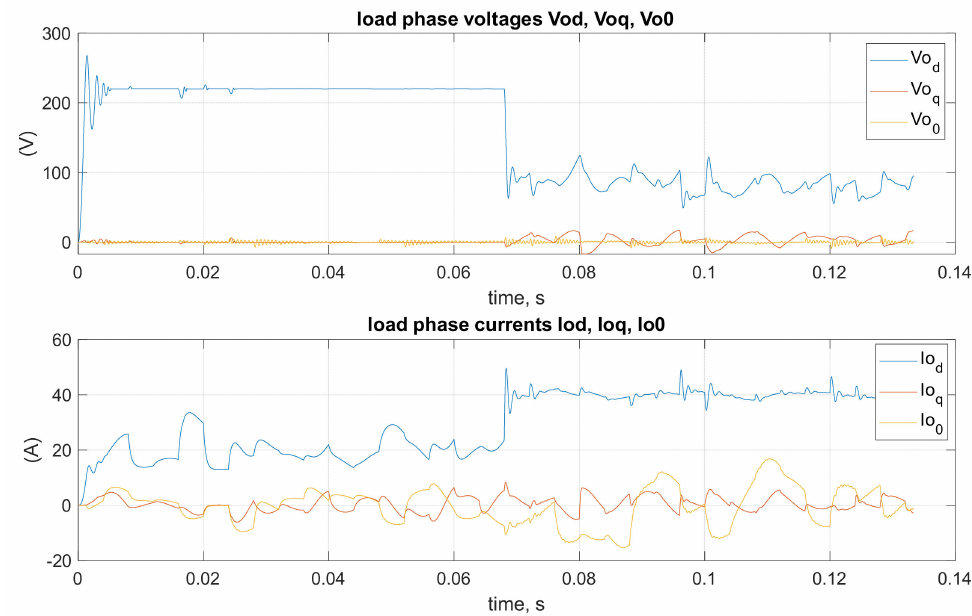
Figure 22. Load voltage V o and load current I o with limitations on control and a steep increase in the load at the time of 0.068 s, when the system does not provide appropriate voltage of the load V o